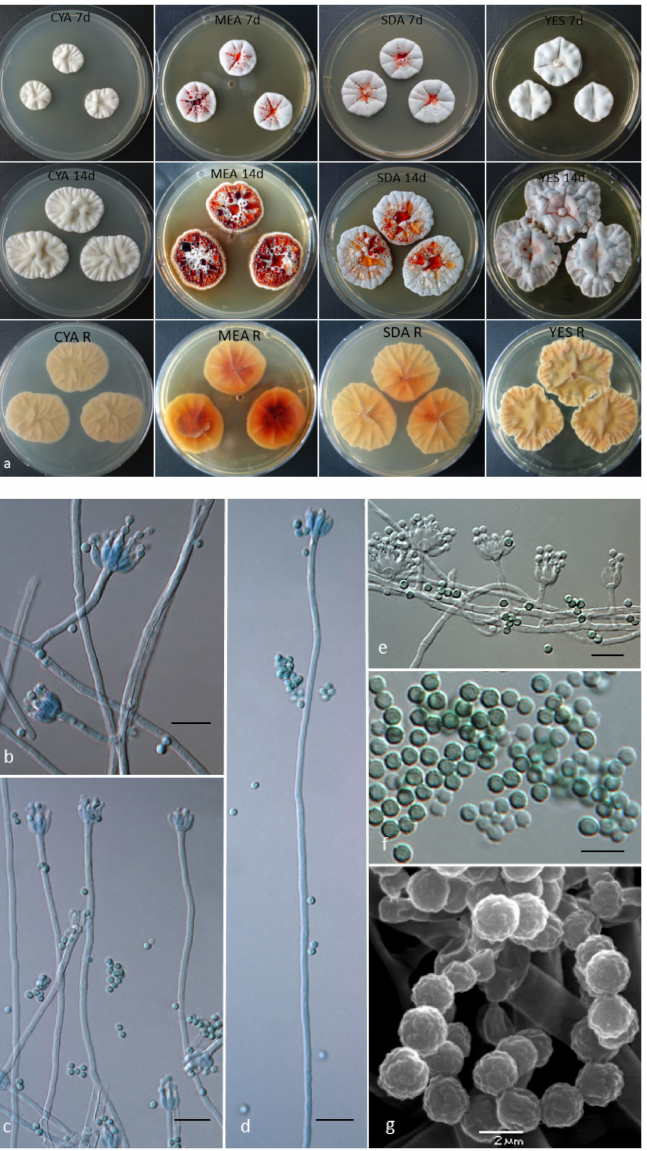
Figure 1. Penicillium krskae BiMM-F280. ( a ) Colonies on CYA, MEA, SDA, and YES; rows, from top to bottom: obverses after 7 and 14 days, and reverses after 14 days at 25 ◦ C. ( b – e ) Conidiophores with conidia (on MEA, after seven days); ( f ) conidia (on MEA, after 14 days); ( g ) scanning electron microscopy (SEM) of conidia (on MEA, 20 days). Scale bars = 10 µ m ( b – e ), 5 µ m ( f ), 2 µ m ( g